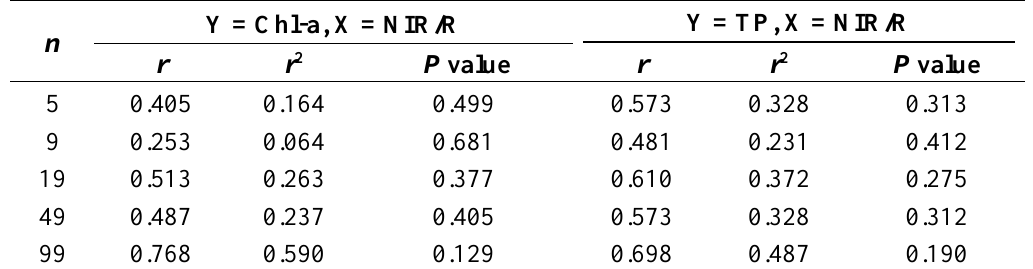
Table 4. Correlation analysis results between ln(NIR/R) and either ln(Chl-a) or ln(TP) using the average method .